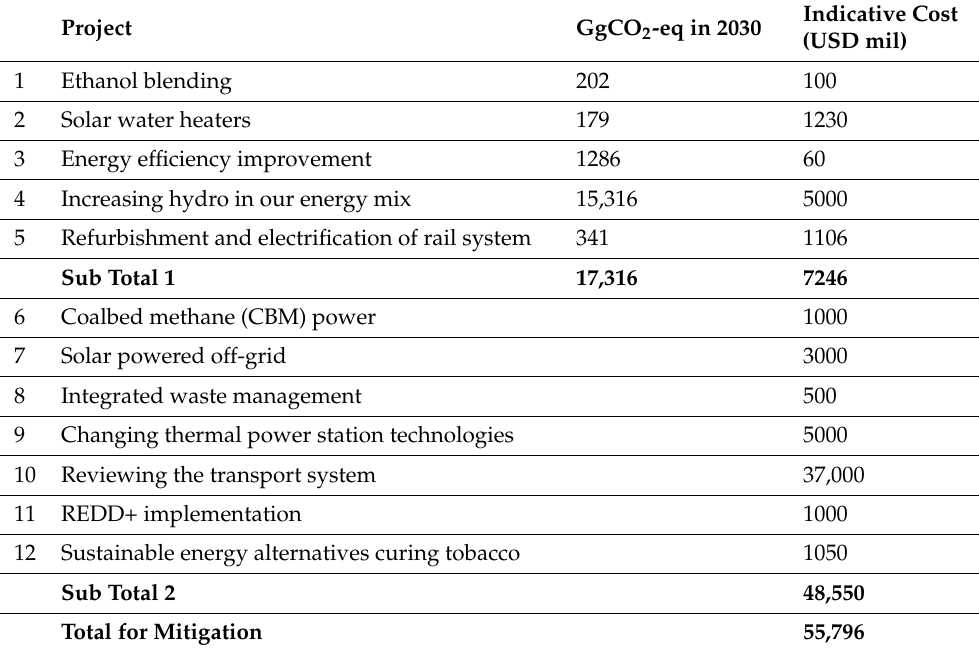
Table 1. A summary of the measures as reported in the NDCs are provided below. The NDC considers projects numbered from 1 to 12. Projects 1–5 have mitigation potentials and indicative costs. While 6–12 indicate total costs